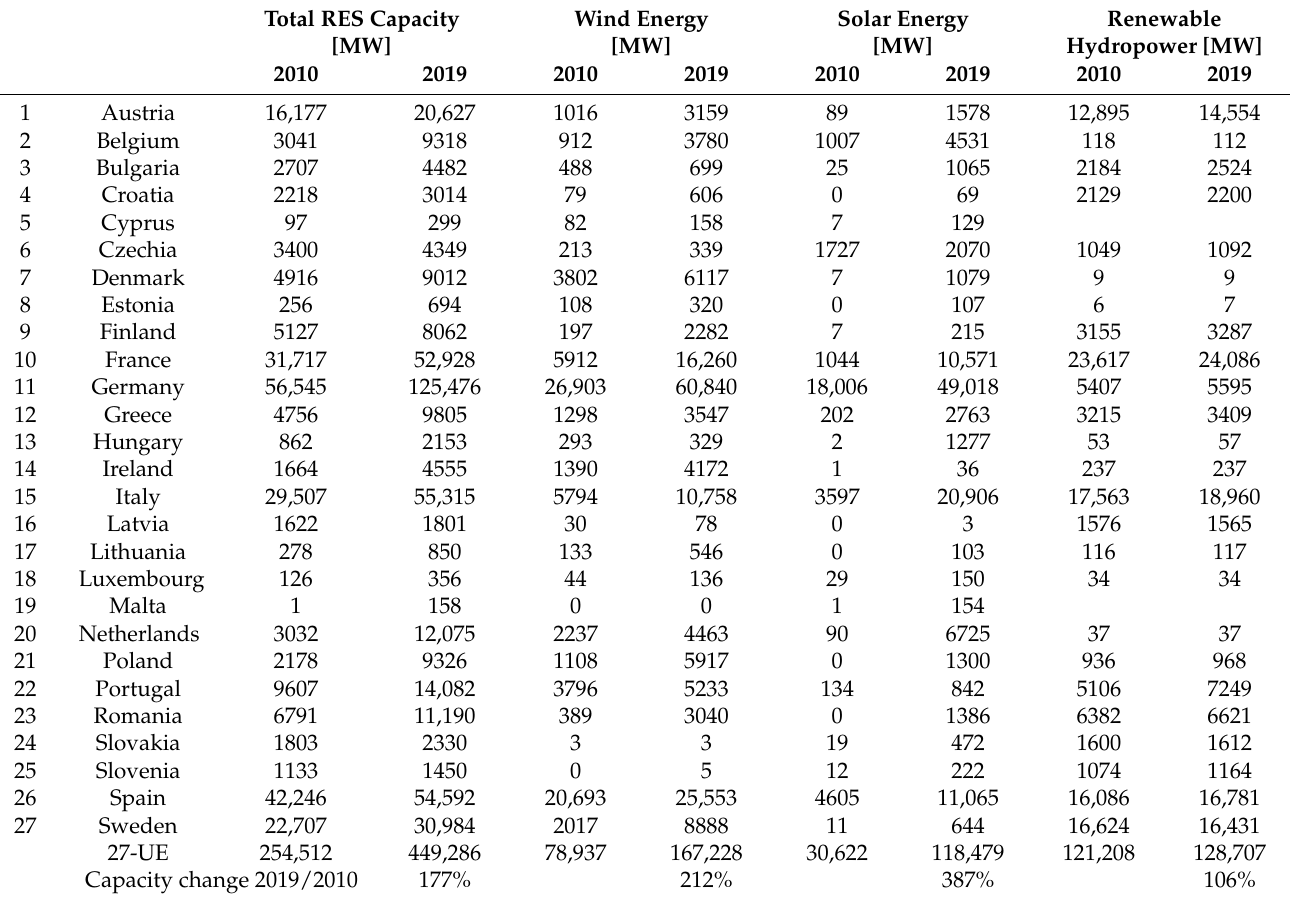
Table 1. The capacity generated by selected RES technologies in form of power plants and other installations in the EU